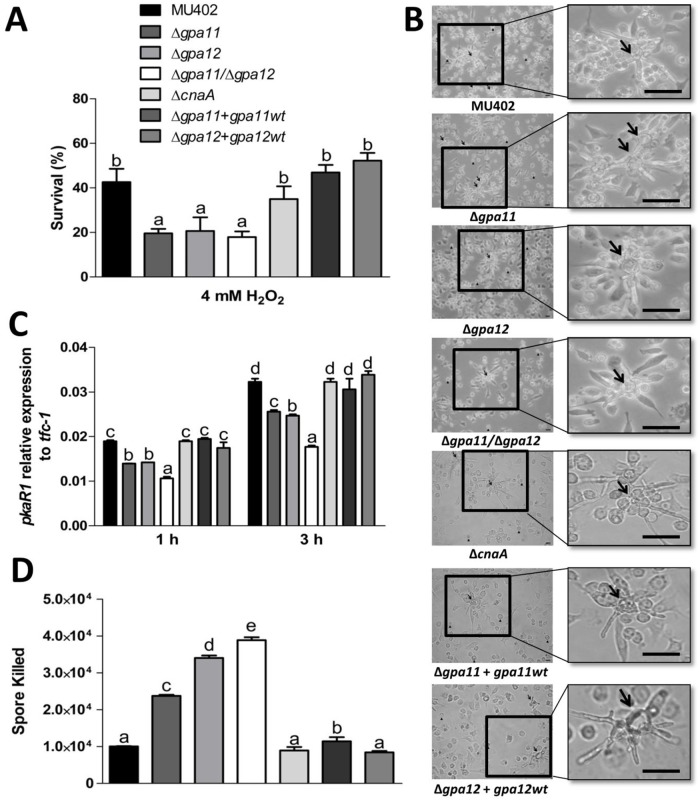
Effect of mutations in gpa11 and gpa12 in the viability of sporangiospores from M. circinelloides in H2O2 and macrophage interaction.A) Spores from different strains were treated or not with 4 mM H2O2 and incubated at 28 °C on YPG. Survival was obtained from colonies grown for 24 h from the quotient of colonies from treatment versus no treatment. B) Germination of spores during macrophage interaction after 3 h was observed under direct observation by light microscopy (40 X) Scale bar = 20 μm. Arrows indicate germinating hyphae and head of arrows indicate swelling spores. C) The pkaR1 mRNA levels were quantified by qRT-PCR after 1 and 3 h of spore and macrophage interaction. D) Quantitation of killed spores by qPCR using tfc-1 after 3 h of incubation with mouse macrophages. A ΔCt analysis was performed to compare the mRNA and gene levels between the samples. Figures show the average of three independent experiments. Statistically significant differences are indicated by different letters (ANOVA and Fisher’s tests; p ≤ 0.05).